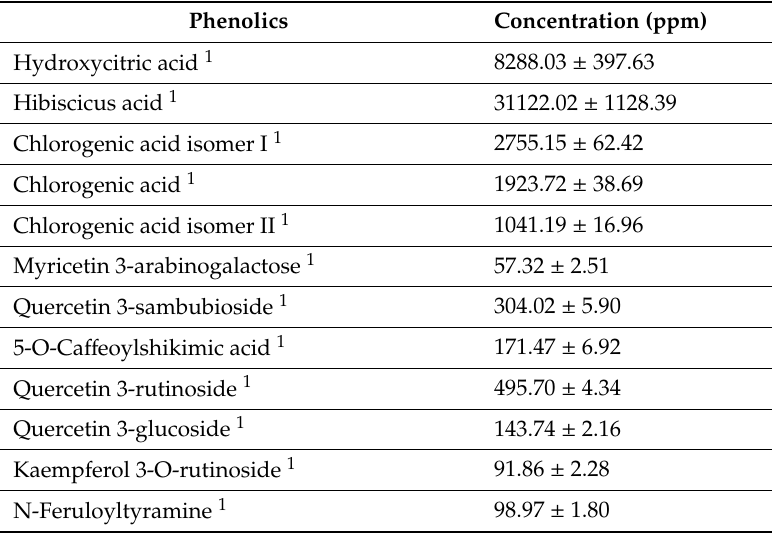
Table 4. Polyphenolics detected in Hisbus sabdari ff a